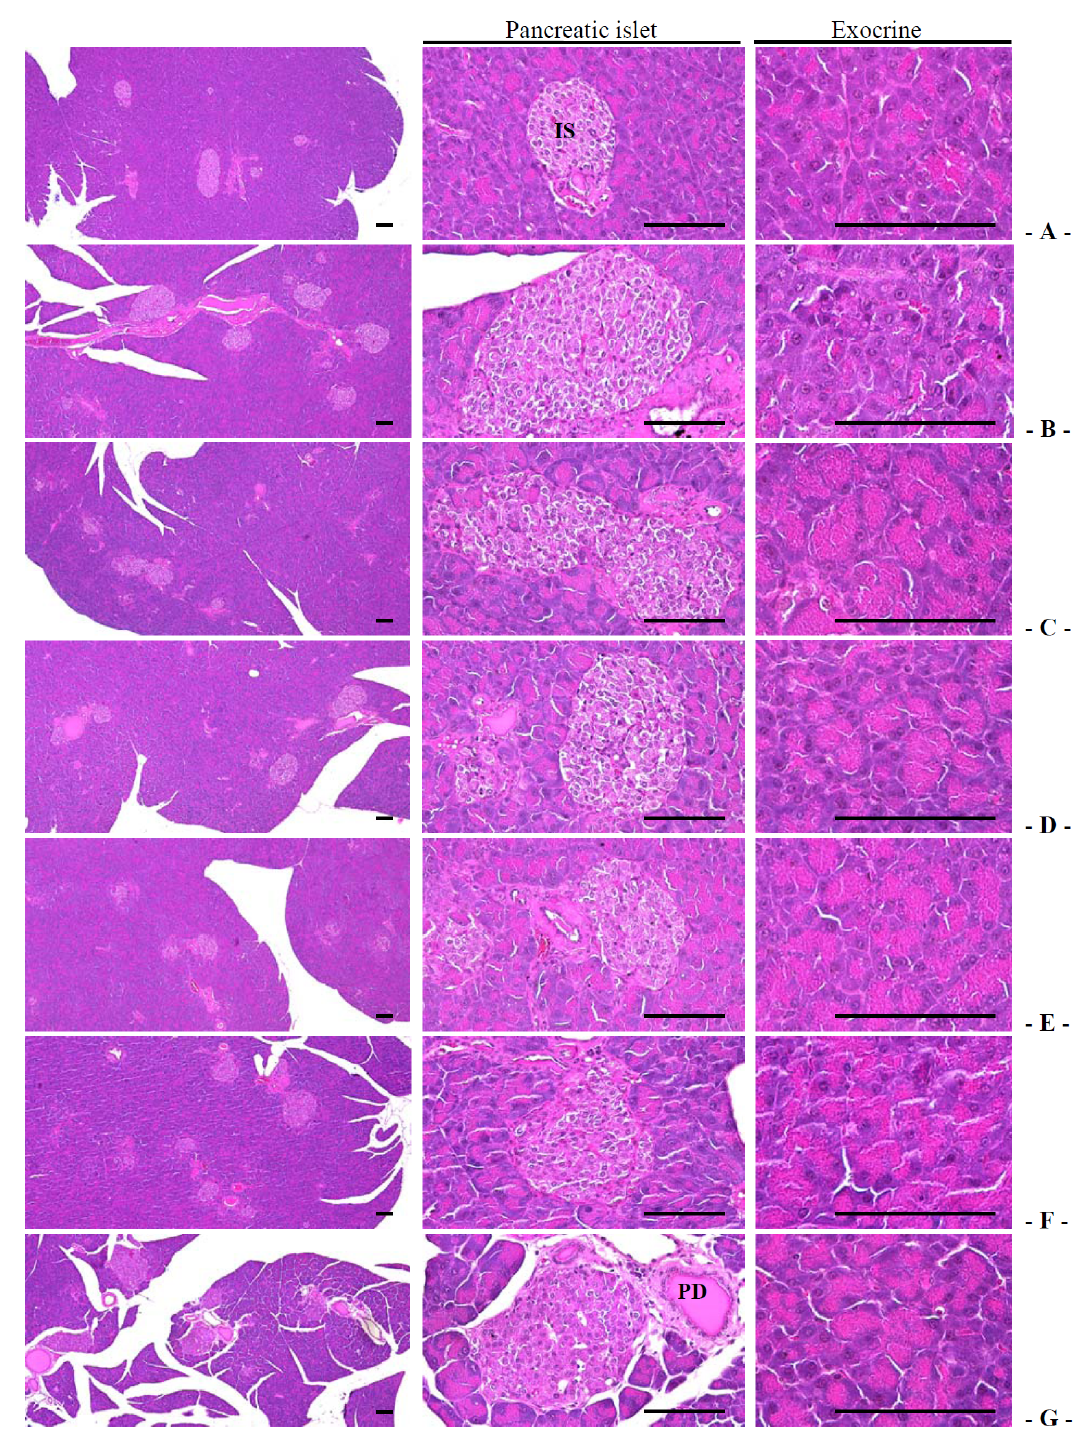
Figure 4. Representative histological images of the pancreas, taken from intact normoglycemic or db/db mice. ( A ) Intact control mouse; ( B ) db control mouse; ( C ) metformin 250 mg/kg treated db mouse; ( D ) GT 400 mg/kg treated db mouse; ( E ) fGT 400 mg/kg treated db mouse; ( F ) fGT 200 mg/kg treated db mouse; ( G ) fGT 100 mg/kg treated db mouse. GT, Green tea aqueous lyophilized extracts; fGT, Aquilariae Lignum-fermented green tea aqueous lyophilized extracts; IS, pancreatic islet; PD, pancreatic secretory duct. All Hematoxylin and Eosin stain. Scale bars = 80